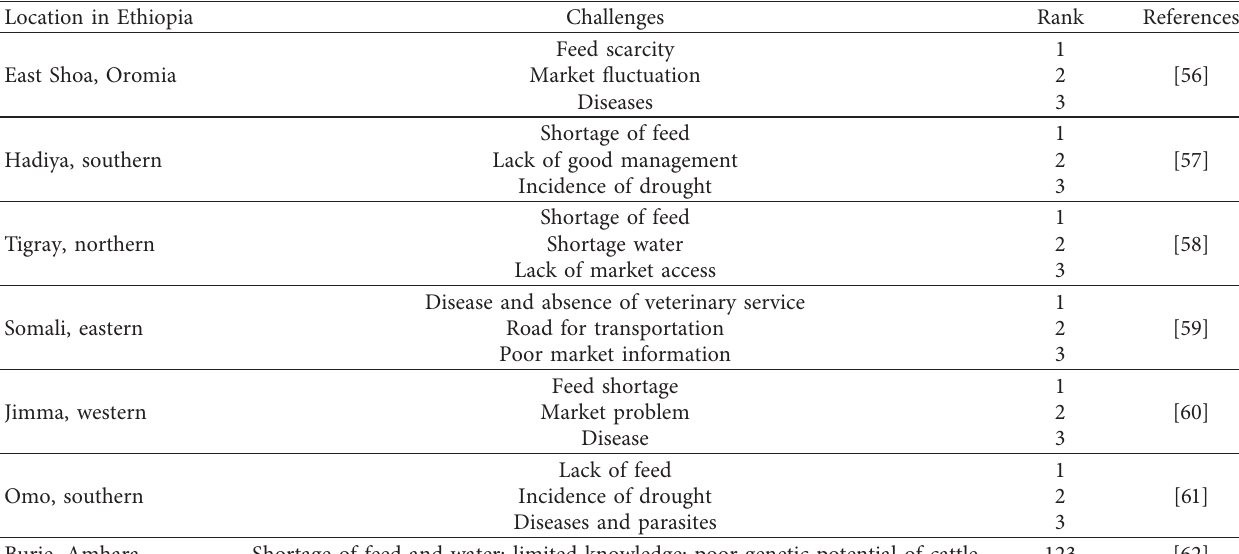
Table 1: The recently identified constraints of beef cattle production/fattening practice in different parts of the country as expressed by